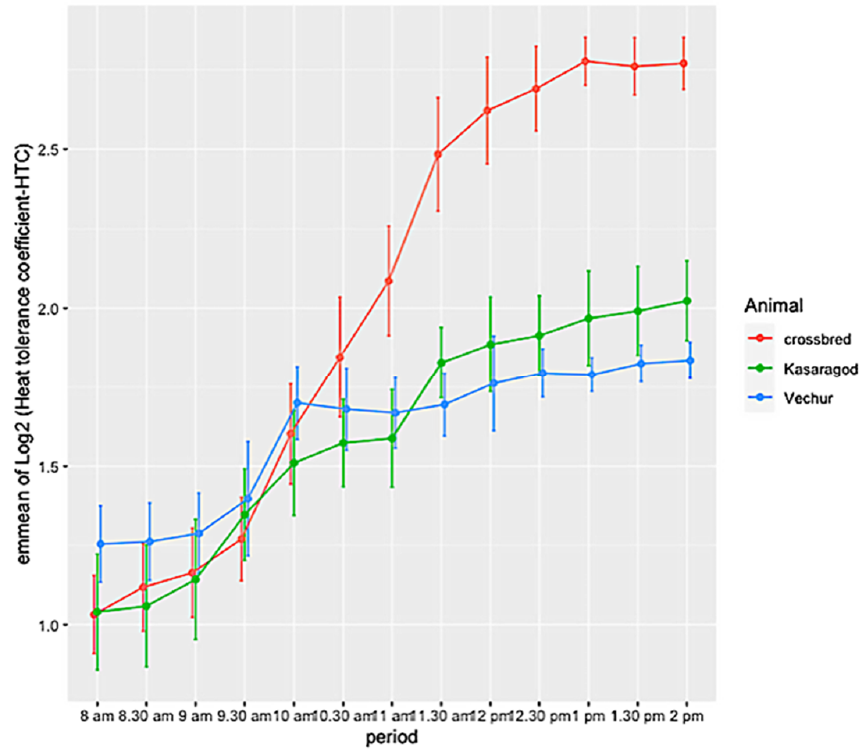
Figure 1. Estimated marginal means (emmean) of the heat tolerance coefficient (HTC) in crossbred, Kasaragod, and Vechur cattle, from 08:00 to 14:00.